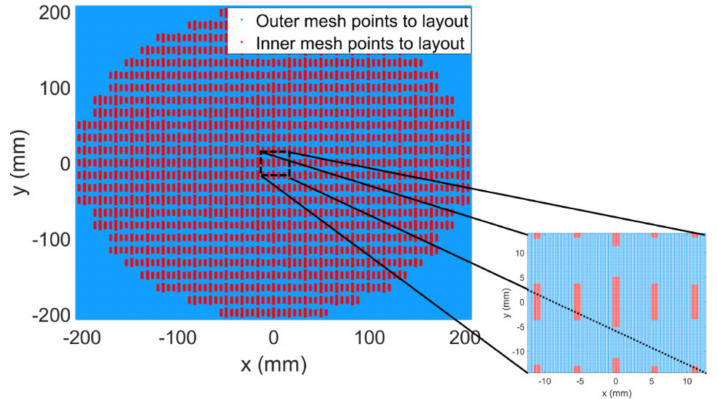
Figure 4. Equi-spaced mesh points x = x m , y = y n , z = − h 2 0 < m < N x , 0 < n < N y that are inside of the